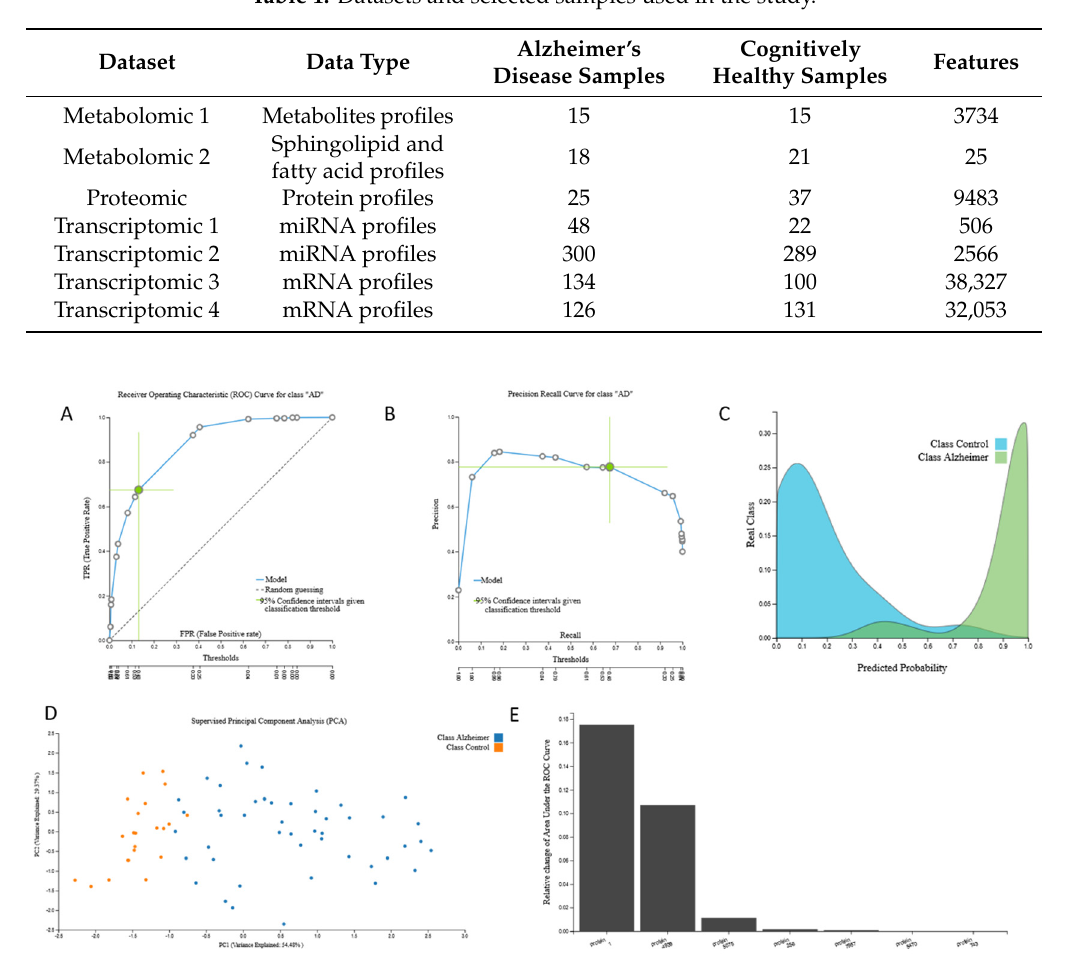
Table 1. Datasets and selected samples used in the